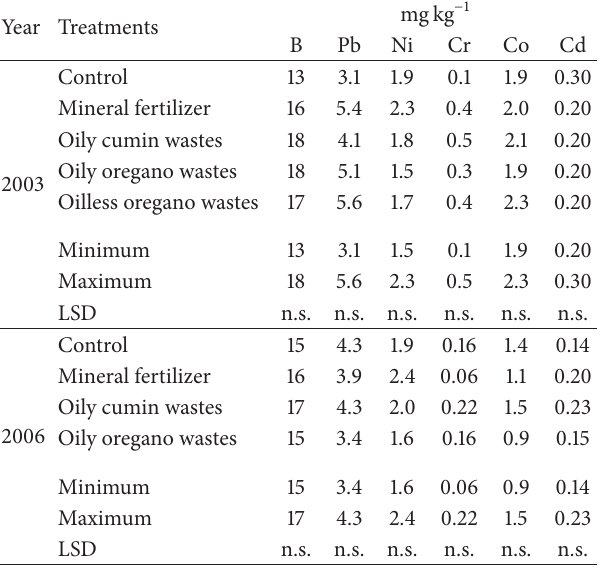
discussed by Power and Woods [29]. According to Hu et